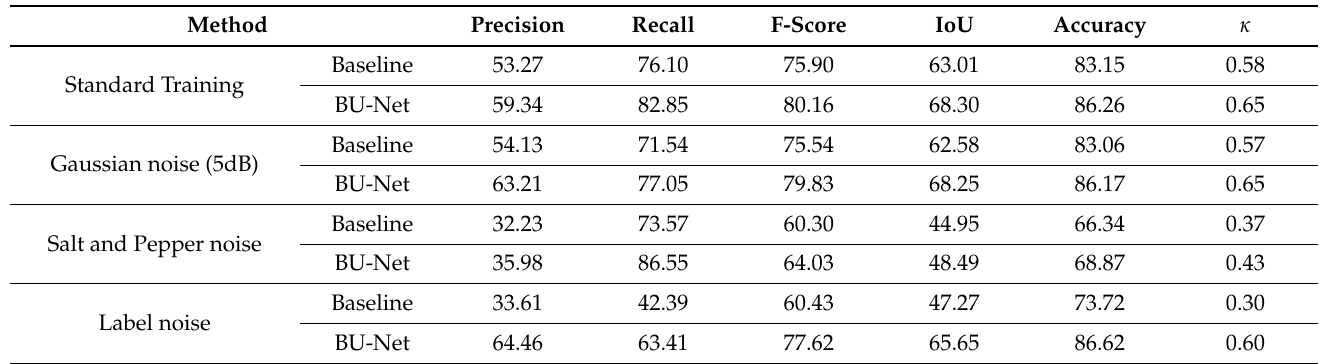
Table 5. Comparison of the effect of different types of